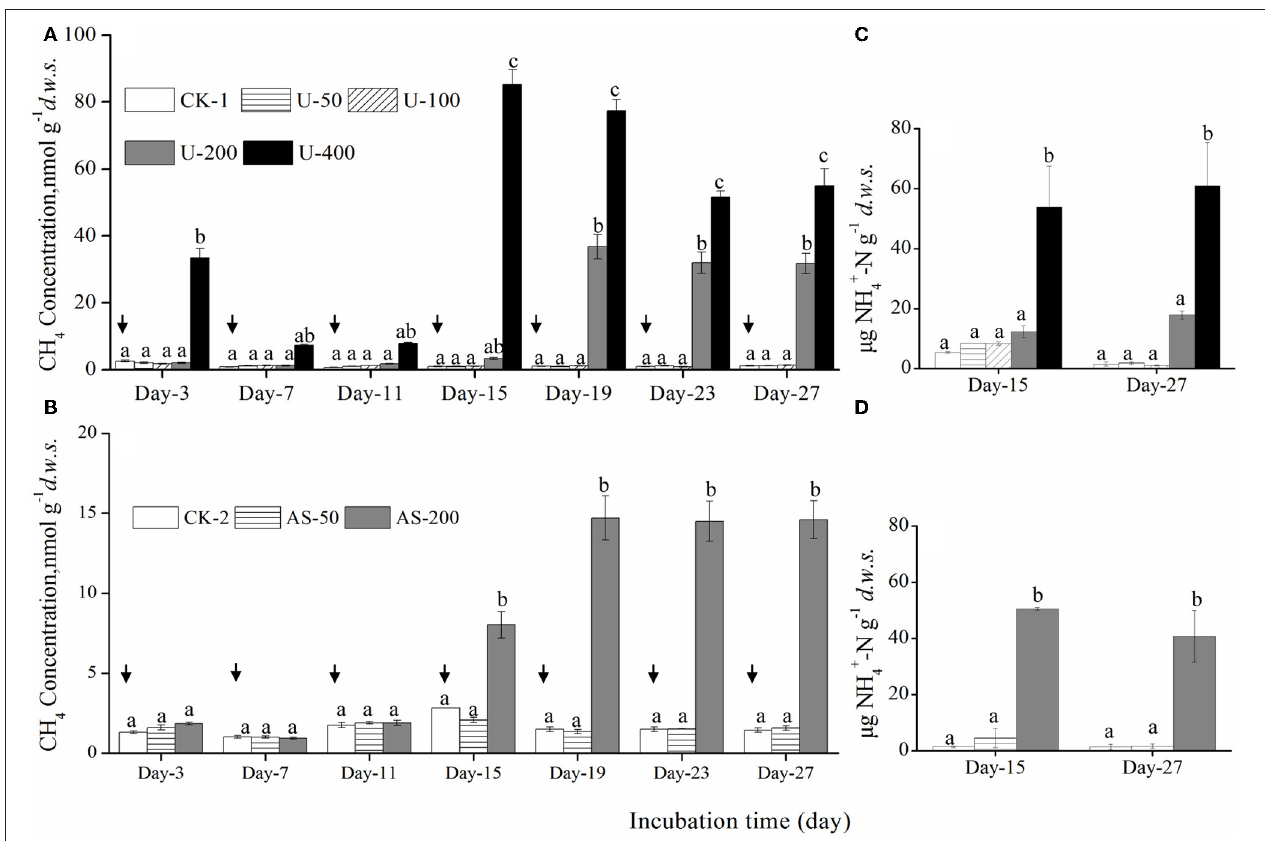
FIGURE 1 | Changes in the CH 4 concentrations in the headspaces of soil microcosms amended with urea (A) or ammonium sulfate (B) over an incubation course of 27 days as well as changes in the concentrations of NH + 4 -N in the soil microcosms (C,D) . The designations CK-1, U-50, U-100, U-200 and U-400 represent the soil microcosms that received no fertilization, 50, 100, 200, and 400 μ g urea-N/ g d.w.s ., respectively. The designations CK-2, AS-50, and AS-200 represent the soil microcosms treated with no